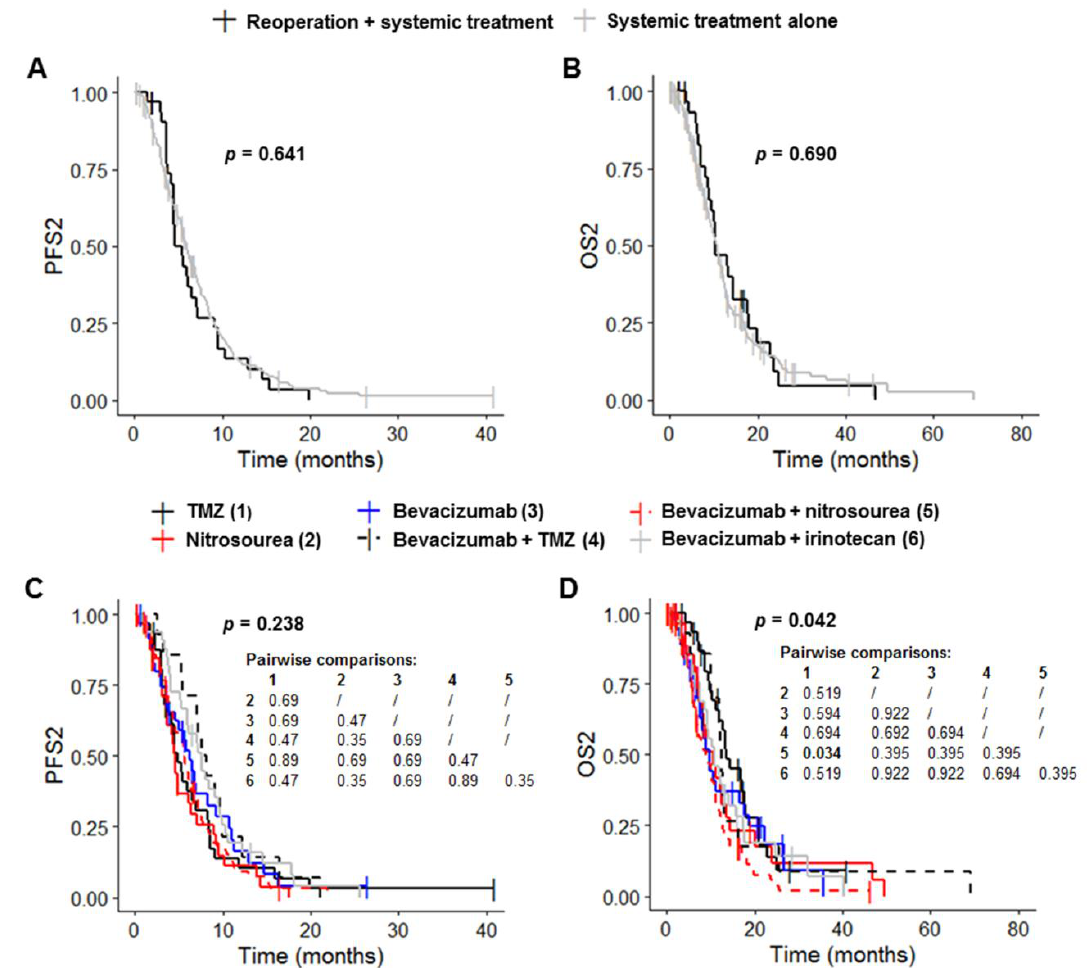
Figure 3. Survival outcomes for patients on systemic treatment. ( A , B ) Kaplan–Meier curves for survival stratified for systemic treatment with reoperation ( n = 32) and systemic treatment without reoperation ( n = 195) (( A ) PFS2; ( B ) OS2). ( C , D ) Kaplan–Meier curves for survival stratified for the six most frequent systemic treatment regimens: TMZ rechallenge ( n = 32), nitrosourea monotherapy ( n = 32), bevacizumab alone ( n = 36) or combined with TMZ ( n = 14), nitrosourea ( n = 80) and irinotecan ( n = 33) (( C ) PFS2; ( D ) OS2). Abbreviations: OS2, overall survival after first progression; PFS2, progression-free survival after first progression; TMZ, temozolomide.